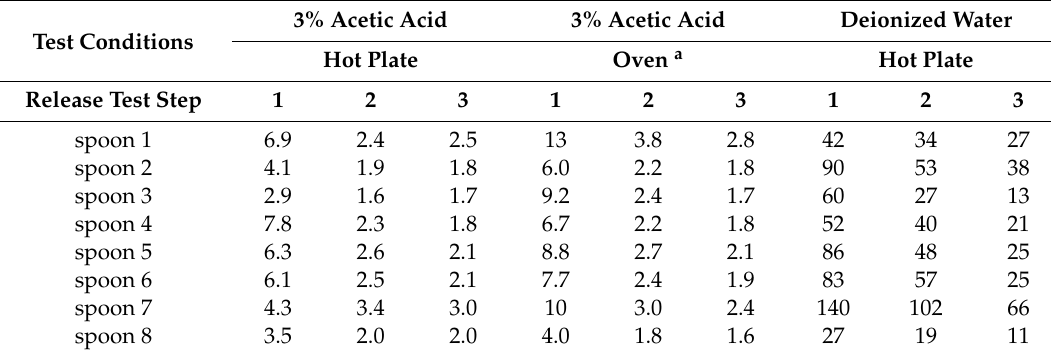
Table 4. Molar ratio of formaldehyde to melamine in release test solutions (formaldehyde results on hot plates corrected by a factor of 1.4).